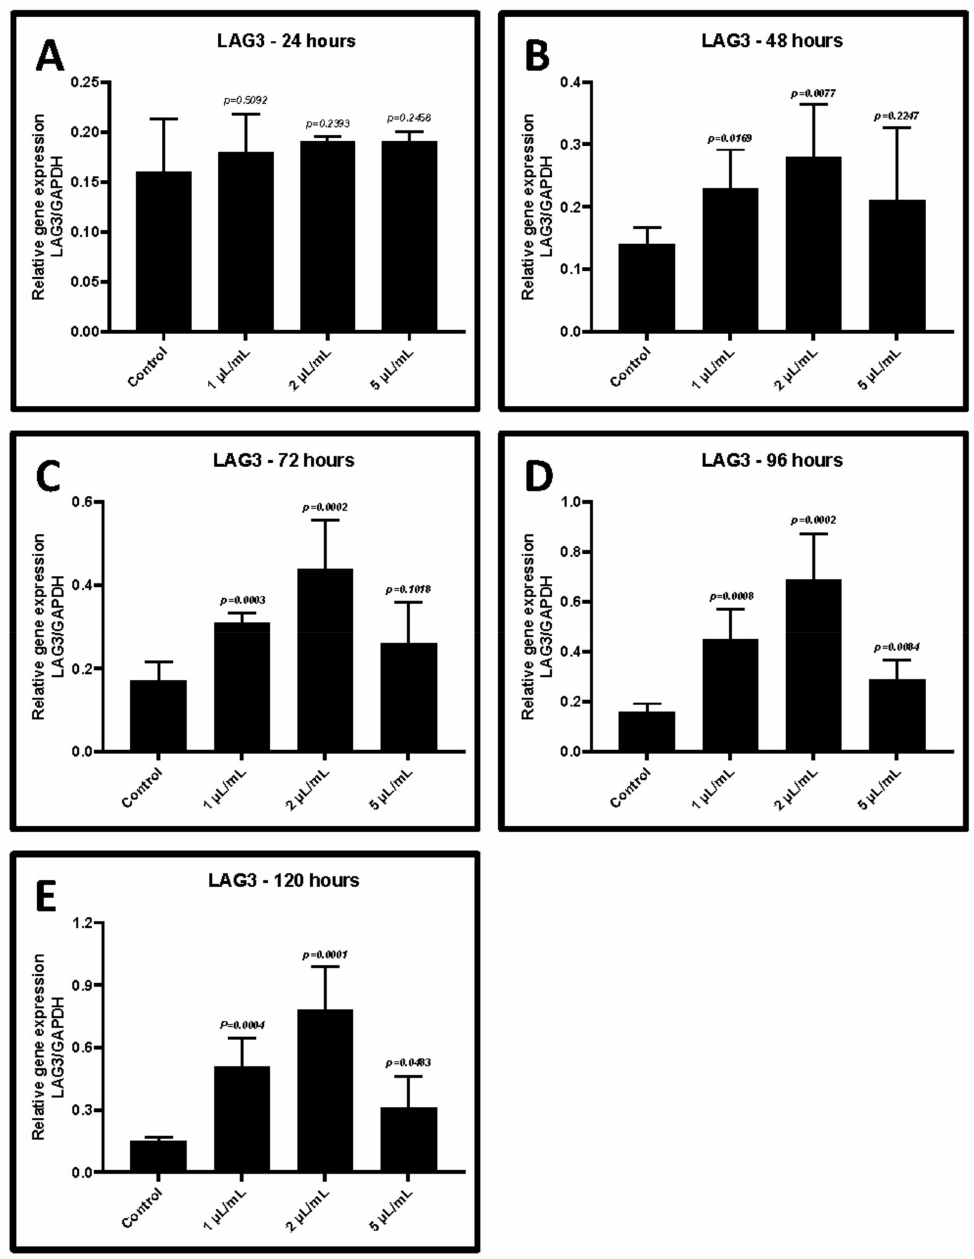
Figure 5. Relative gene expression of LAG-3 in CD3+ T lymphocytes treated with different concentra- tions of GCF (1, 2, and 5 µ L/mL). ( A ) Comparative gene expression of LAG-3 after 24 h of treatment. ( B ) Comparative gene expression of LAG-3 after 48 h of treatment. ( C ) Comparative gene expression of LAG-3 after 72 h of treatment. ( D ) Comparative gene expression of LAG-3 after 96 h of treatment. ( E ) Comparative gene expression of LAG-3 after 120 h of treatment. LAG-3 : lymphocyte-activation gene 3, GCF: gingival crevicular